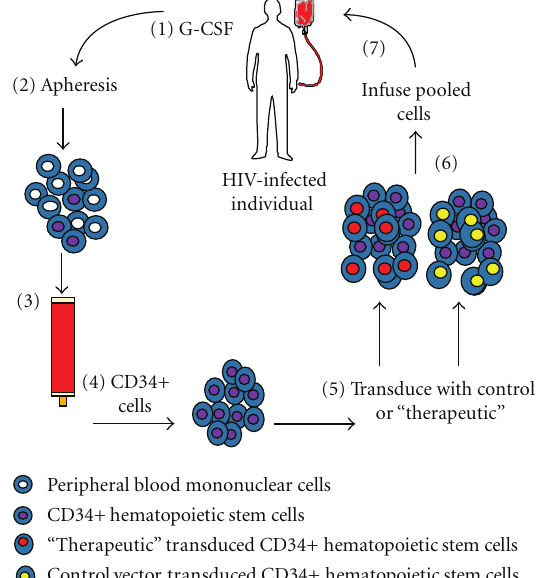
Figure 2: The figure shows the prototypic phase I trial design in which CD34+ HSC were obtained from post G-CSF apheresis product that is CD34+ selected. The CD34+ cells were then transduced with either control or OZ1-containing vector and both transduced populations (control and OZ1) mixed and infused into the individual. (1) Subjects are injected with a course of G-CSF to mobilize CD34+ HSC from the bone marrow to the peripheral blood. (2) Apheresis product is obtained. (3) The mononuclear cell fraction is applied to a CD34+ isolation system. (4) CD34+ cells are obtained. (5) These are transduced with either control or OZ1- containing vector (50% of each) to obtain (6) A mixed population of control and OZ1 transduced cells. (7) This mixed population is infused back into the